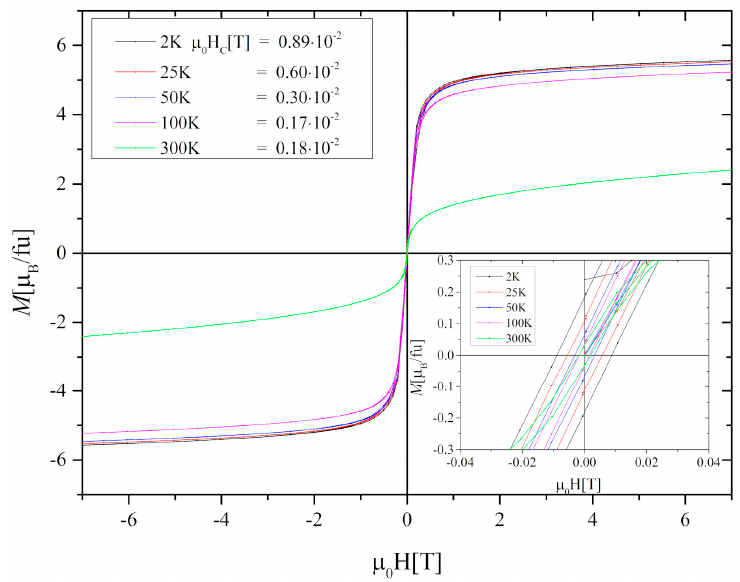
Figure 4. Hysteresis loops of the Gd 0.4 Tb 0.6 Co 2 compound measured at 2 K, 25 K, 50 K, 100 K, and 300 K. The magnetization unit of [ µ B / fu] was derived from [emu / g] using the formula: 1 [emu / g] = 0.1078 × 10 21 / N [ µ B / fu], where N is the number of formula units of Gd 0.4 Tb 0.6 Co 2 in 1 g.